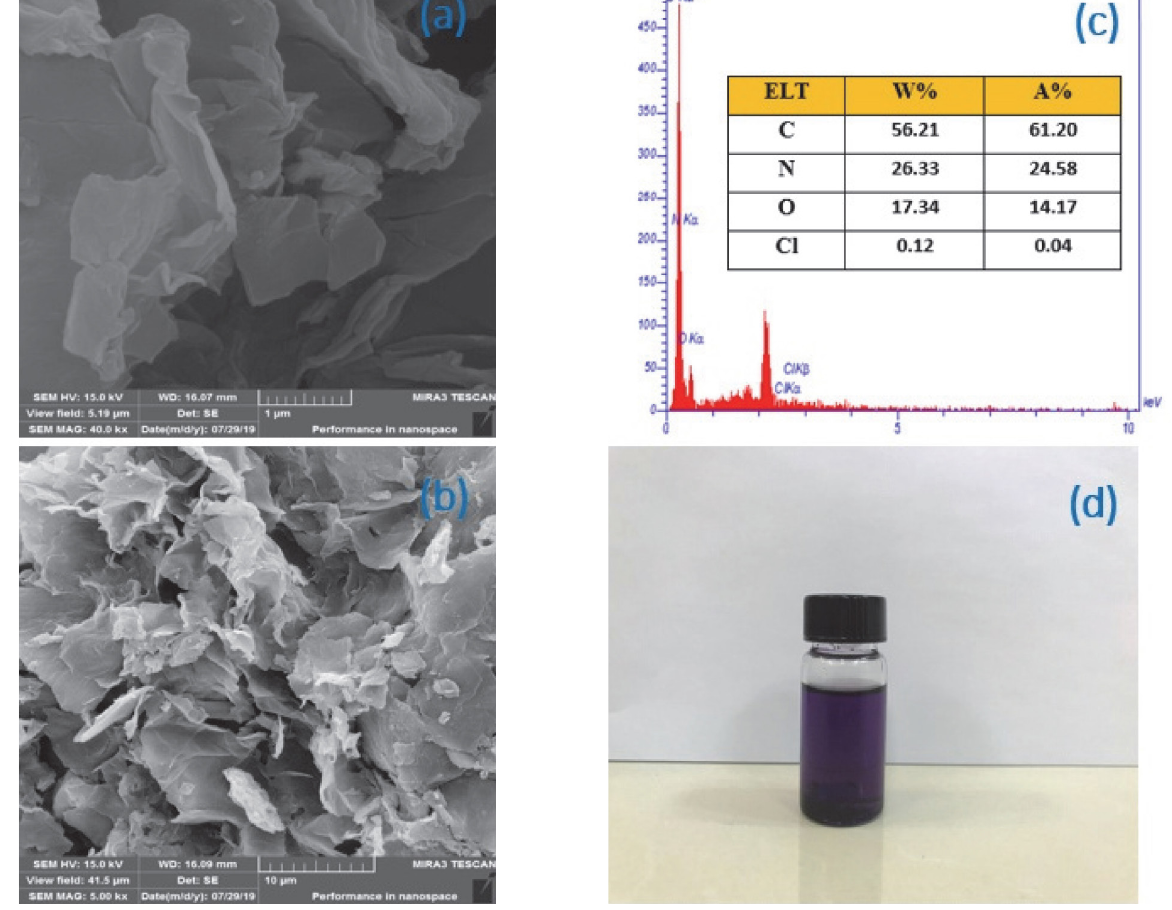
Figure 12. (a,b) SEM and (c) EDS images of the recycled GO/PAMAM and (d) extraction of ARS from the ARS-adsorbed GO/PAMAM by ethylenedi-